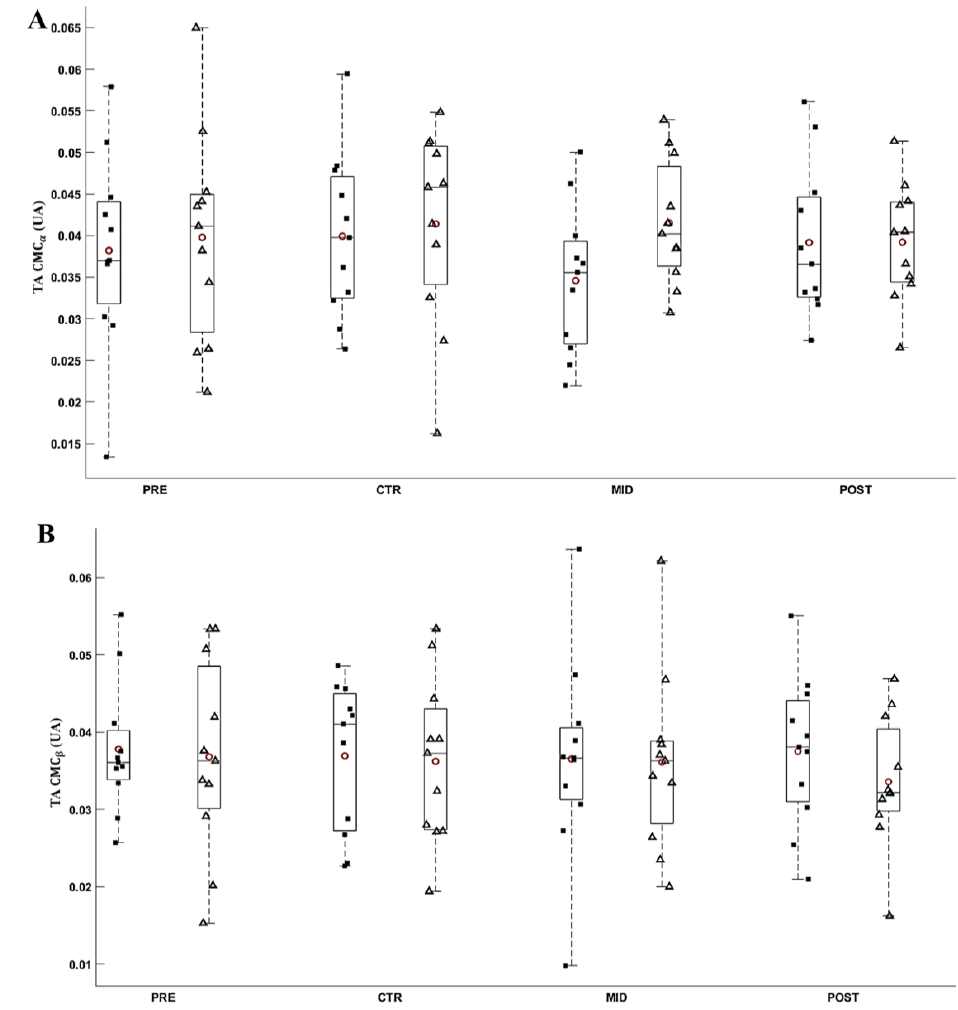
Figure 10. Average α ( A ) and ß ( B ) CMC TA during submaximal contractions computed according to the torque levels, T 0 (black square) and Ti (white triangle), and evaluation sessions (PRE, CTR, MID, POST sessions). Each whiskers box indicates the mean (red circle) and the median (horizontal line). The inferior and superior edges of the box indicate the 25th and 75th percentile, respectively. Black dots represent individual participant performance. Error bars represent the most extreme and non-outlier data points.